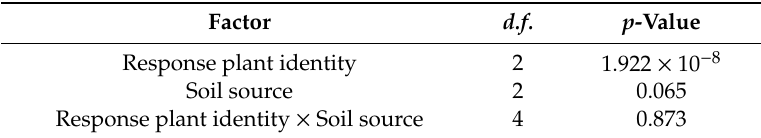
Table 1. Results of linear mixed model examining Phase I soil source, Phase II response plant identity, and the interaction between these two